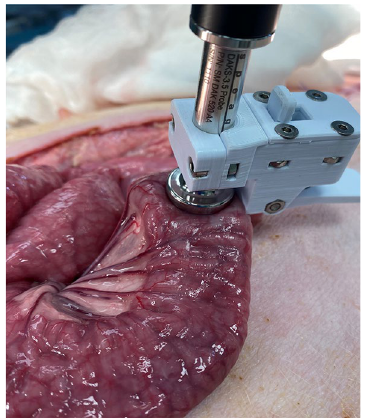
Figure 3. Experimental